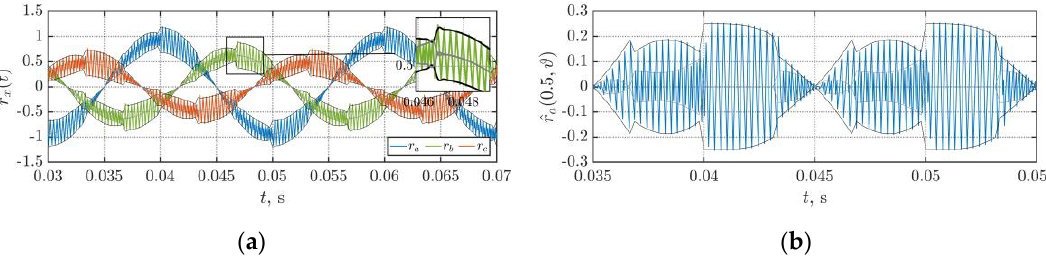
Figure 14. Primary (black) and secondary (gray) envelopes in case of DPWM2 at m = 0.5 and f sw = 3.6 kHz: ( a ) Normalized phase currents; ( b ) Normalized phase current ripple.